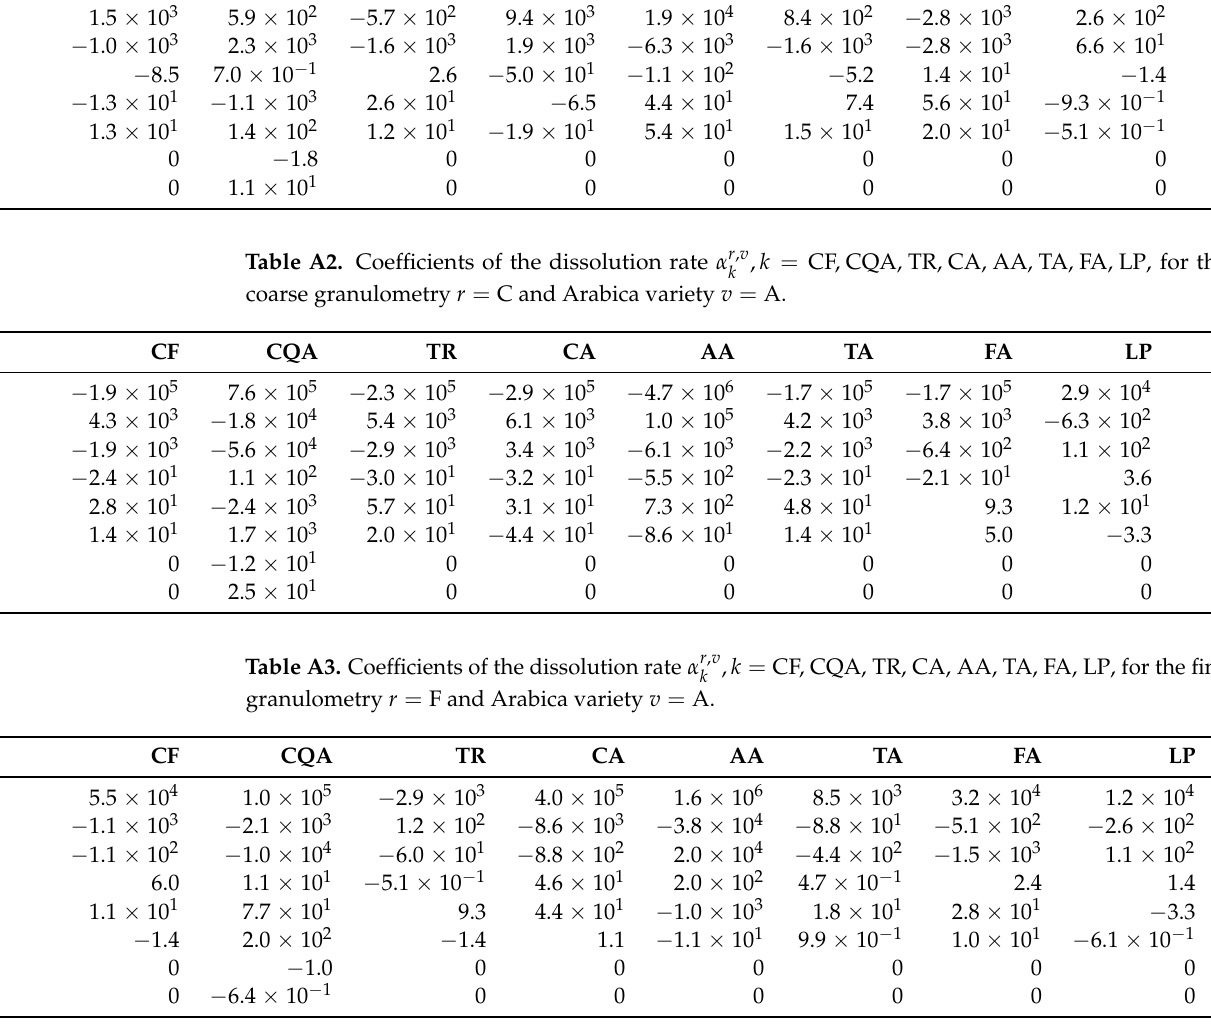
Table A1. Coefficients of the dissolution rate α r , v optimal granulometry r = O and Arabica variety v = A.